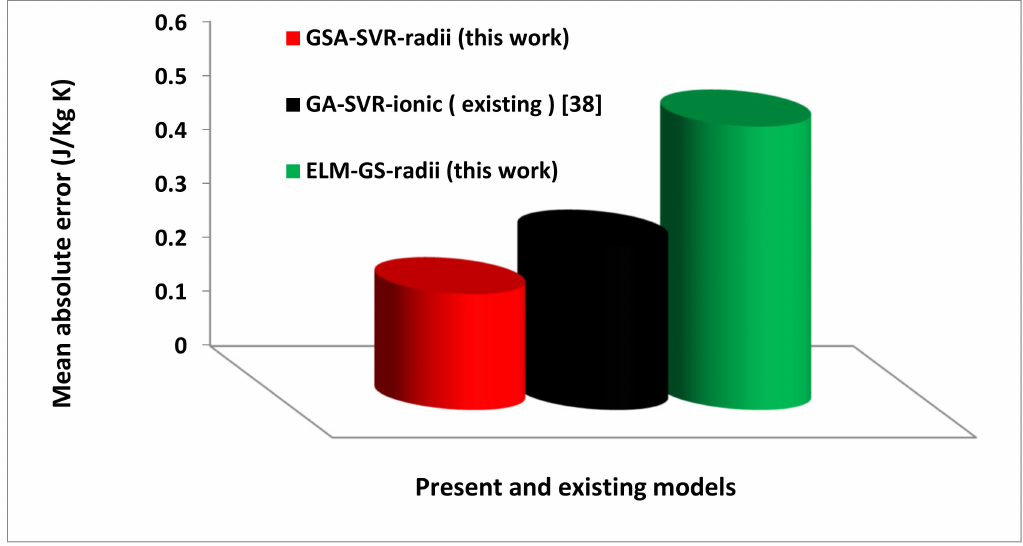
Figure 11. Comparison between the present and existing ionic radii-based models using the mean absolute error metric.